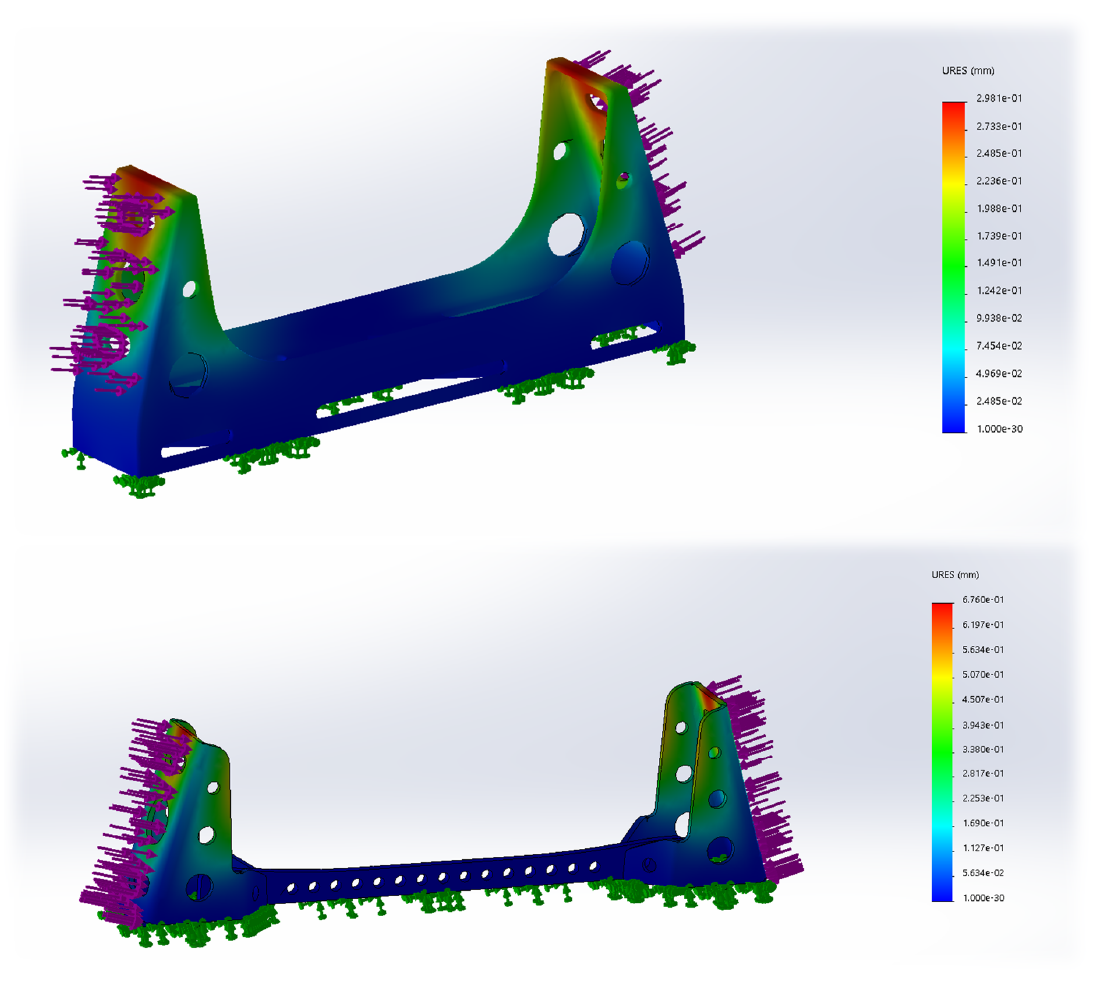
Figure 31. Comparison of load simulations of both front axles.